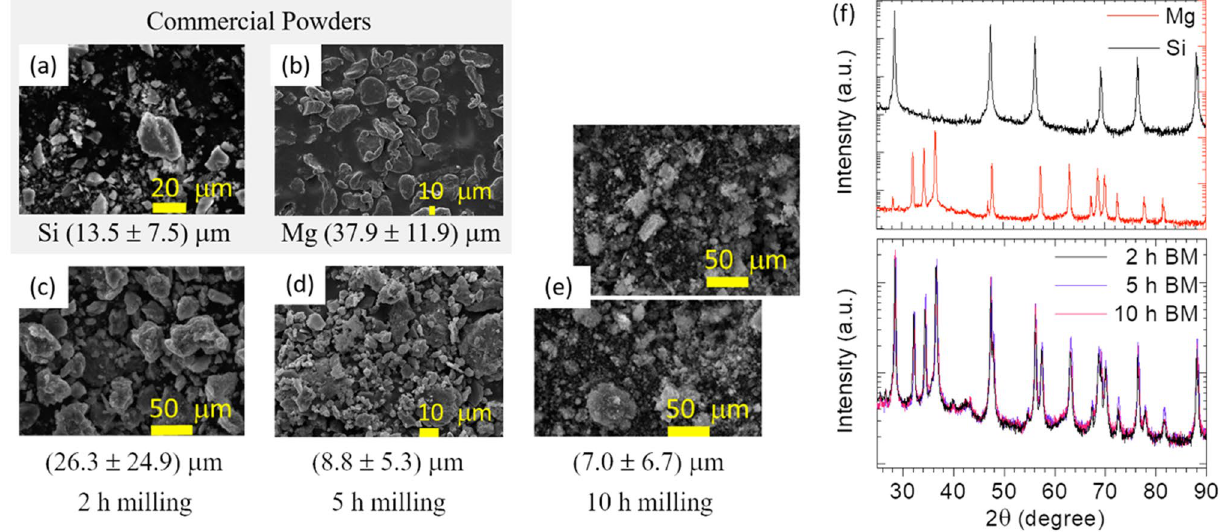
Fig. 2 SEM micrographs of Si and Mg commercial powders before ( a – b ) and after milling for 2 h ( c ), 5 h ( d ) and 10 h ( e ). The average grain size is indicated together with the standard deviation. The XRD